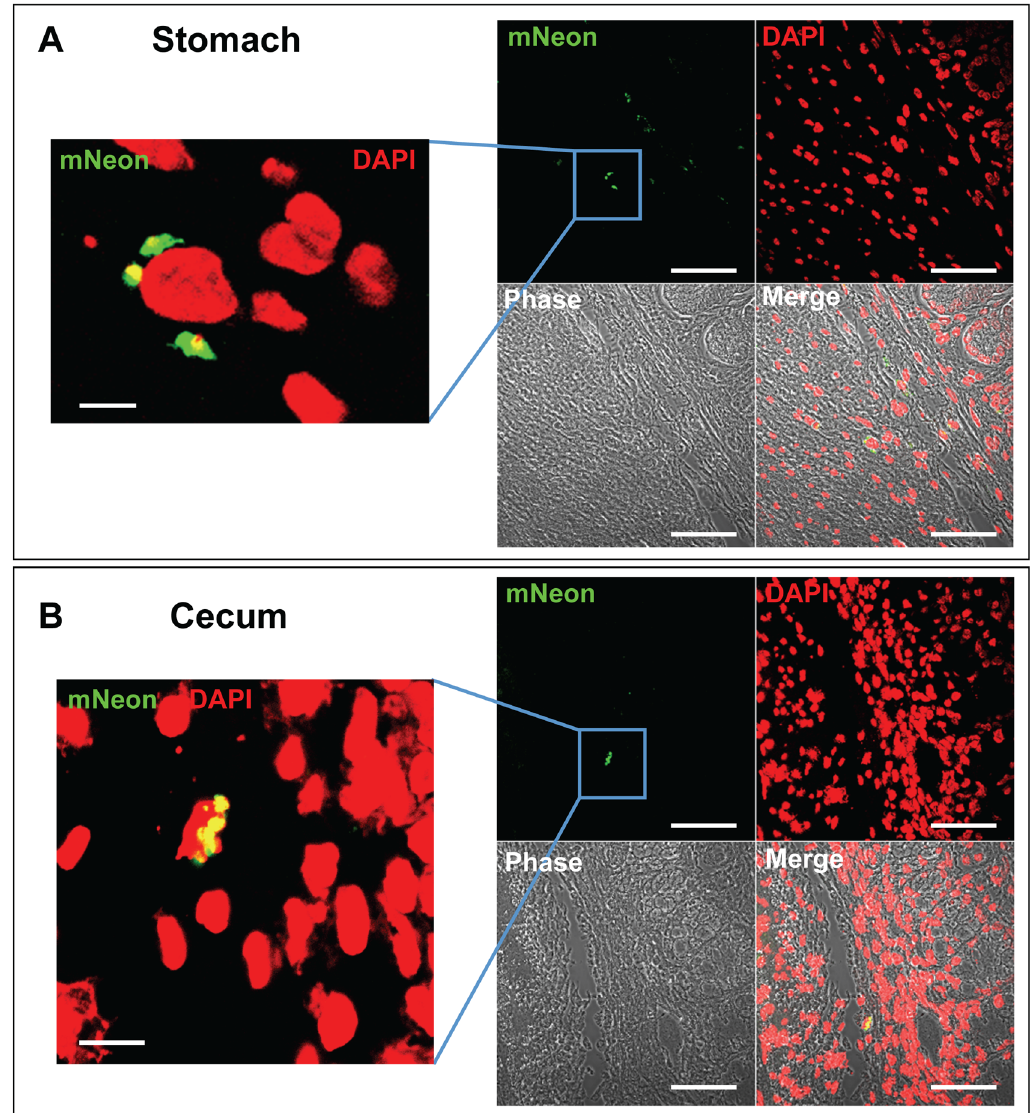
Fig 5. Location of parasites in the stomach and cecum during chronic stage infections. A. Section of stomach tissue from a chronically infected mouse (day 117)—a single slice from a Z-stack through the infected cell (63x scan zoom 0.7). The left-hand panel is a magnified view of the boxed section (63x scan zoom 2.8). The bars represent 5 μm (left hand panel) and 50 μm (right hand panel). B. Section of cecum tissue from a chronically infected mouse (day 117), with a cluster of amastigotes surrounding the nucleus of an infected cell (left hand image, 63x scan zoom 2.5; right hand image, 63x scan zoom